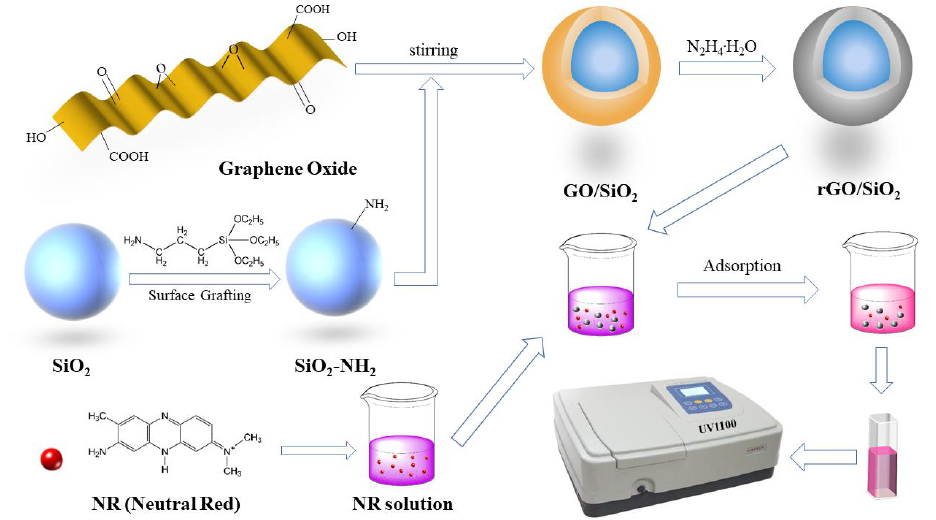
Scheme 1. Illustration showing the formation process of the rGO / SiO 2 composites as a functional adsorbent for the removal of neutral red